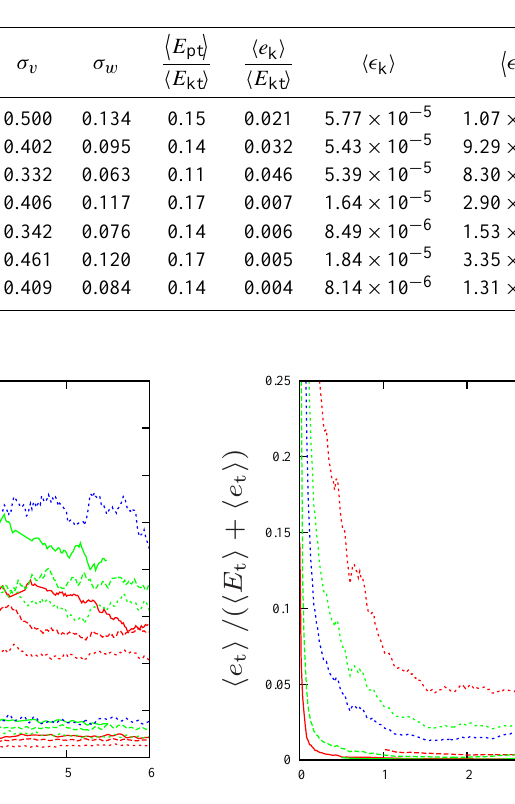
Table 1. Overview of numerical simulations and principal statistics properties of the flow: run identifier; total number of grid points N grid ; resolution 1( m); forcing intensity σ f ( ms − 2 ); turbulent fluctuations σ u ,σ v , and σ w ( ms − 1 ); resolved turbulent potential to kinetic energy ratio (cid:10) E pt (cid:11) / h E kt i ; subgrid-scale to resolved turbulent kinetic energy ratio h e k i / h E kt i ; kinetic energy dissipation rate h (cid:15) k i ( m 2 s − 3 ); potential